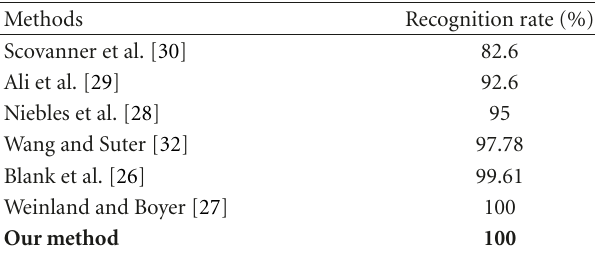
Table 3: Reported results on Weizmann dataset.